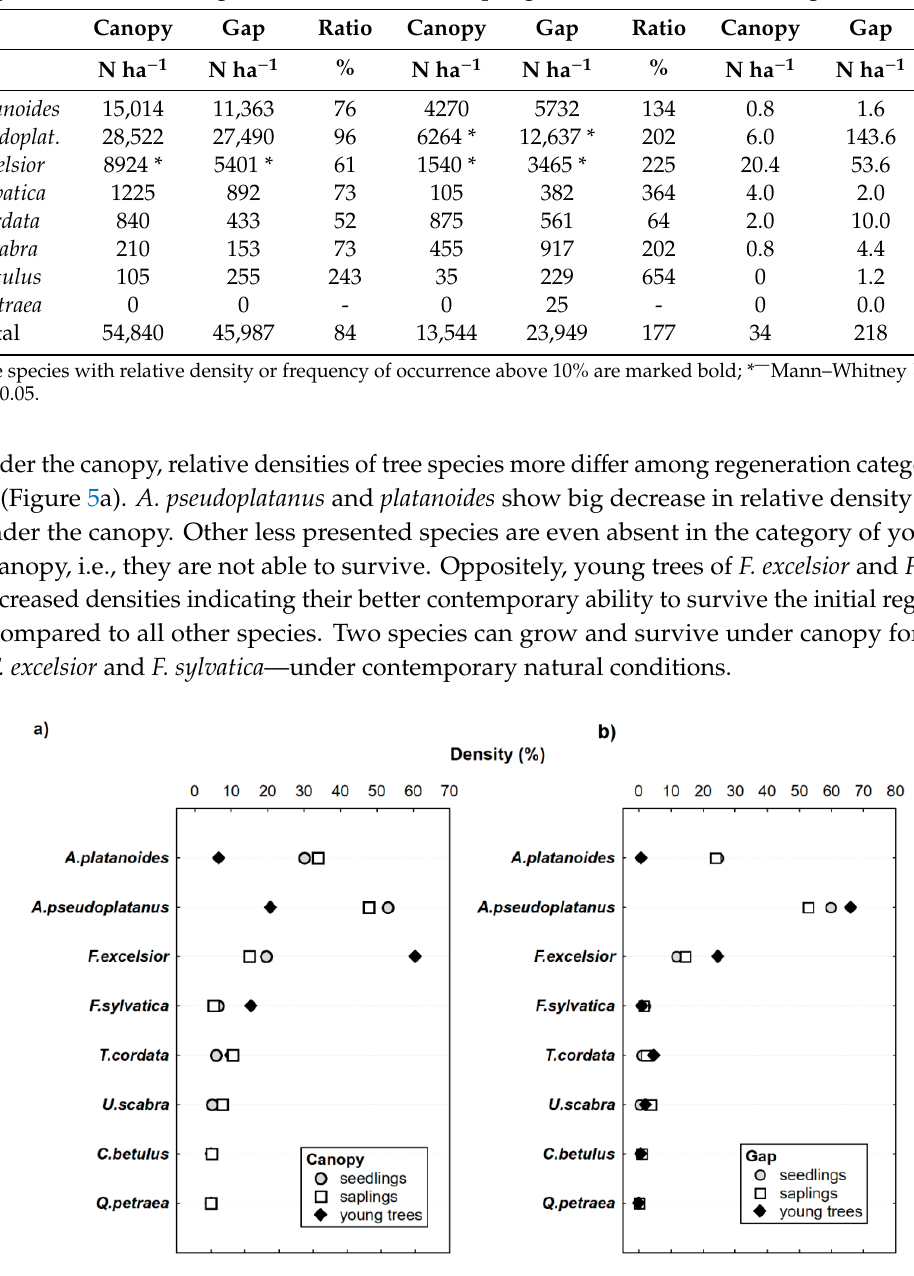
Table 4. Tree species density of natural regeneration in expanded gaps and under closed canopy. Tree Species